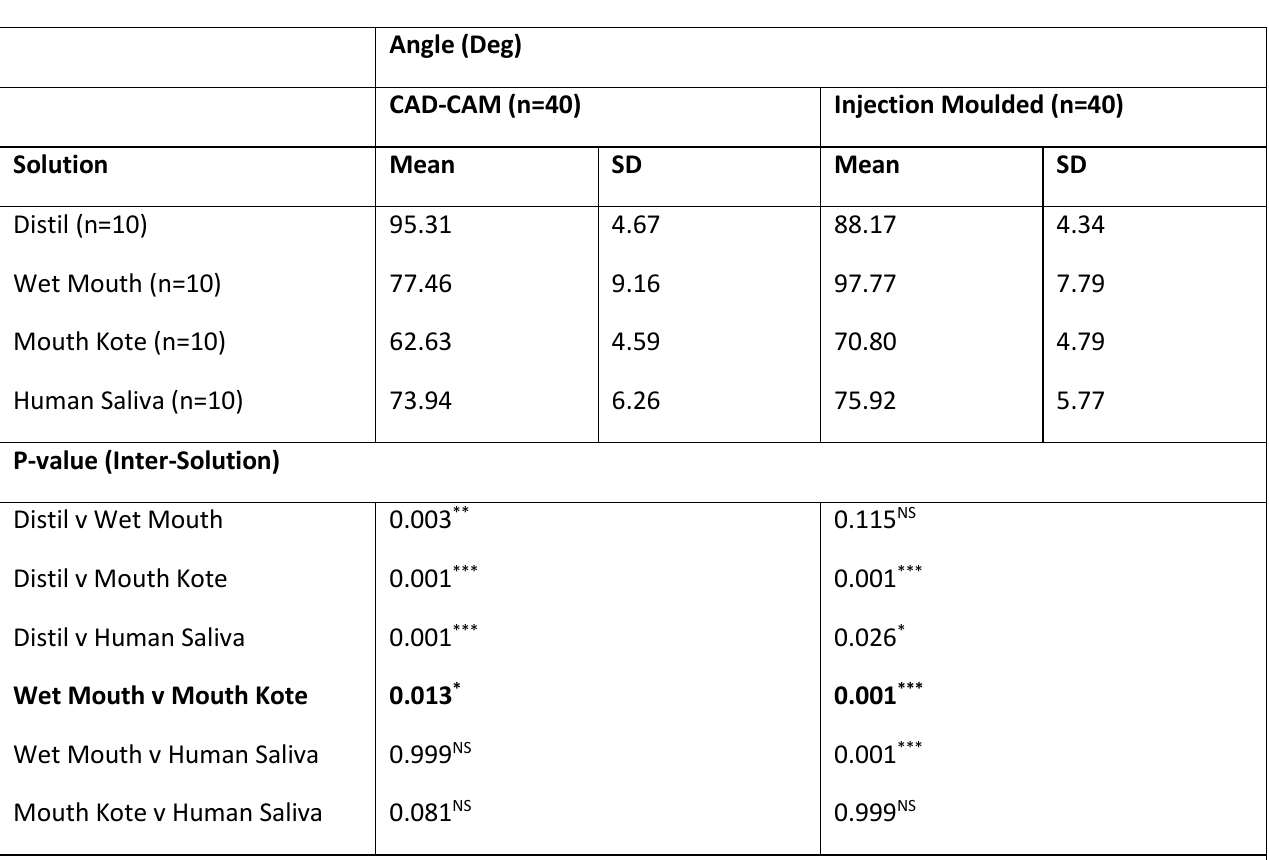
Table 2. Inter-Solution group comparison of mean angular